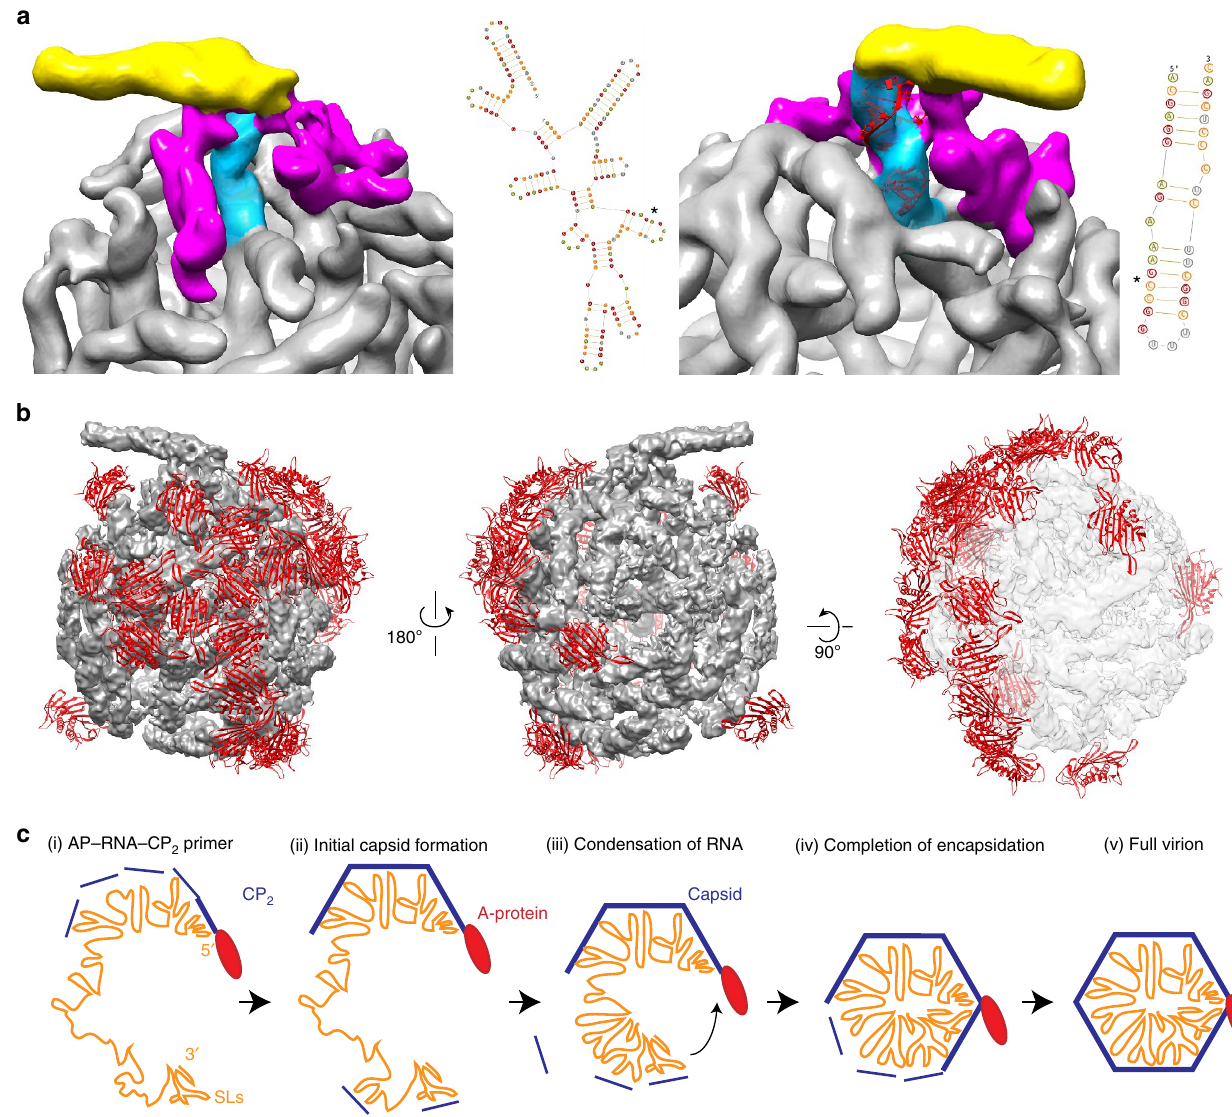
Figure 2 | Proposed RNA densities of known AP binding sites. Left: nucleotides 3,510–3,527 (magenta) and the RNA secondary structure prediction (asterisk marks binding site). Right: nucleotides 388–414 (blue) with fit in density (red) and the secondary structure of the SL ( a ). Asymmetric distribution of SL–CP 2 interactions; the 23 capsid dimers (red) to which the bound RNA (grey) SLs fit the TR are predominantly localized at one side of the capsid ( b ). Proposed model for MS2 virion assembly: AP–RNA–(CP 2 ) n complex forms primer (i) to which CP 2 dimers bind and start to form the capsid (ii), CP 2 is both being recruited by existing SLs and induce new SLs in the RNA (iii) CP 2 induced refolding and binding of the 5 0 end AP binding site results in condensation of the RNA (iv) that enables efficient packaging and formation of a stable virion (v) ( c